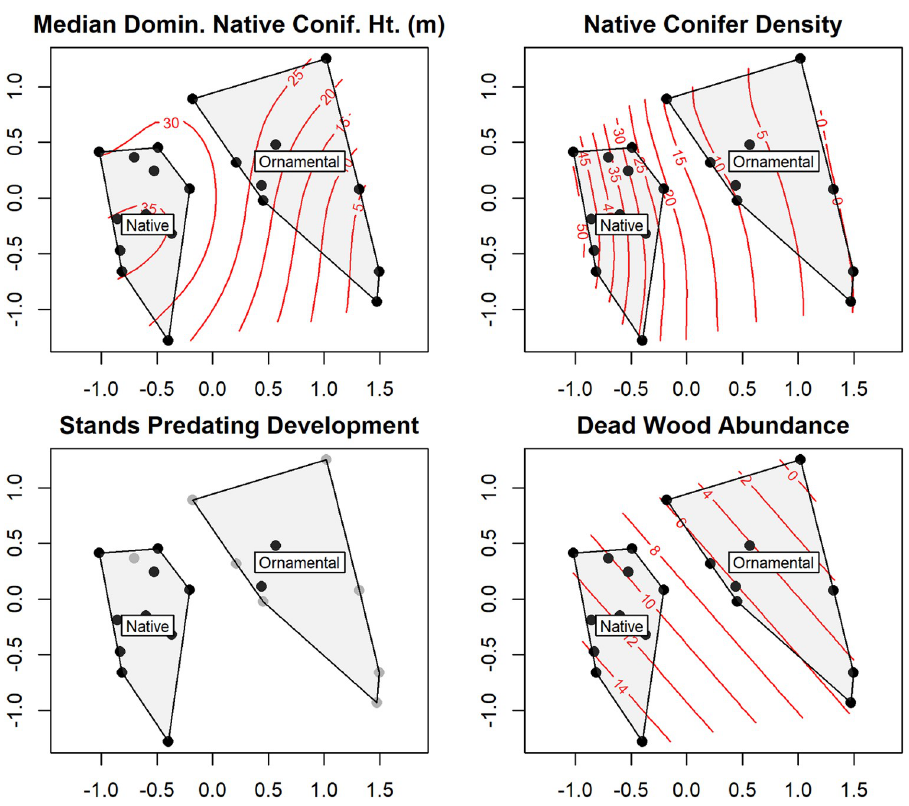
Fig 4. Two dimensional NMDS representation of tree community composition. Median dominant native conifer height, native conifer density, and the presence of stands predating development are associated with the first NMDS axis. Dead wood is associated with both axes. Black dots represent sites with stands predating development, gray dots sites without. Ordination has not been rotated prior to plotting.